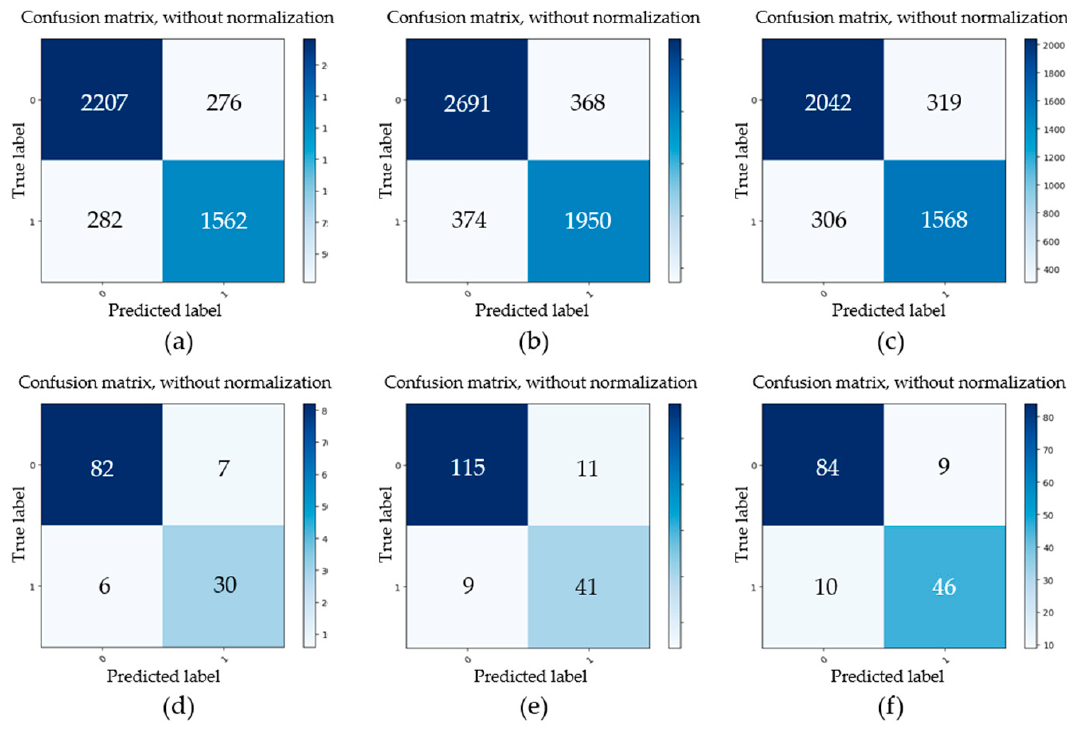
Thirdly, we explored the e ff ect of di ff erent shooting angles on the detection accuracy. Similarly, three test datasets were used for comparison, which were acquired with shooting angles of 15 ◦ and 75 , respectively. For the above datasets, the obtained evaluation parameters ( TP , FP , FN , TN ) of gear pitting and TS are illustrated in Figure 13. Then, six evaluation indexes ( P , R , F 1 , A , FDR , FOR ) under three shooting angles were calculated, which are listed in Table 5. We can easily see from Table 5 that the accuracy of pitting and TS detection decreased with the increase of shooting angle.